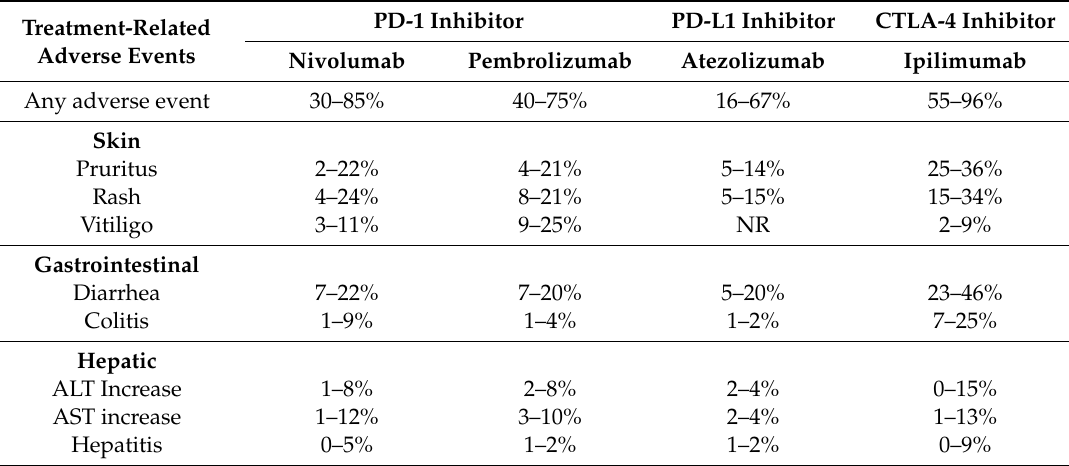
Summary of treatment-related adverse events associated with select checkpoint inhibitor